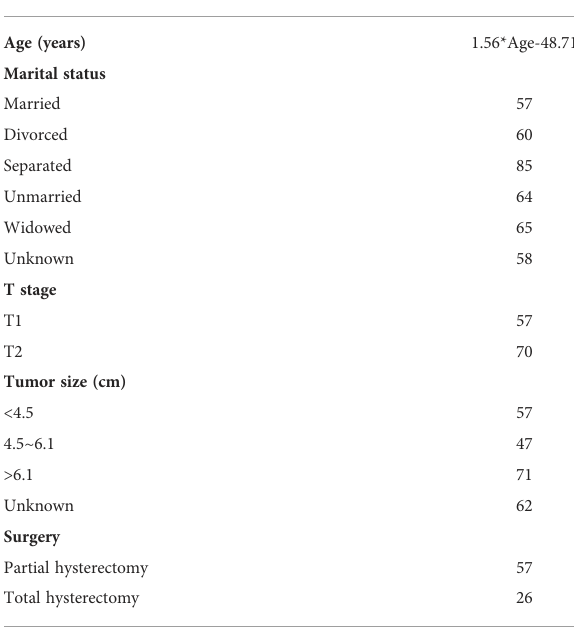
TABLE 4 Nomogram scores of each independent prognostic factor in the FIGO stage I/II ECCC patients.